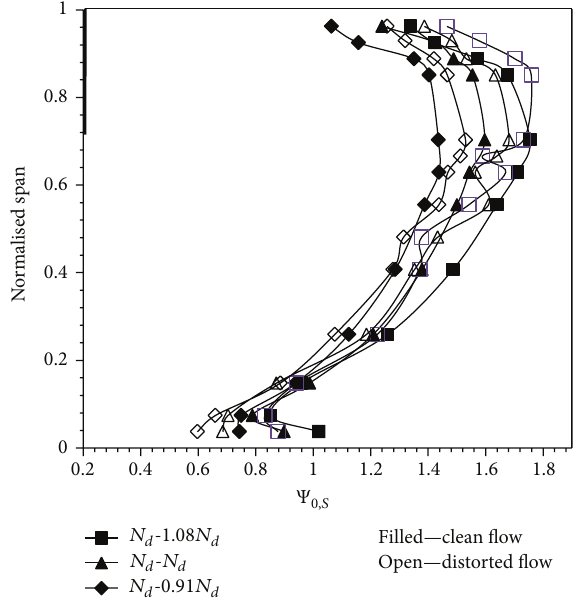
Figure 12: Spanwise variation of total pressure rise coefficient: design mass flow